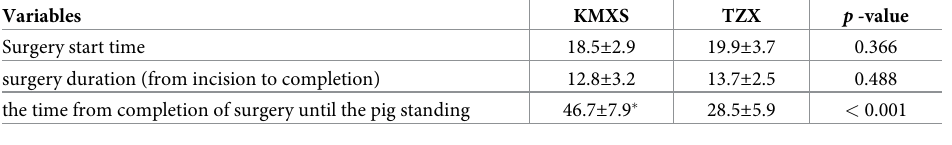
Table 3. Time related with surgical procedures at phase